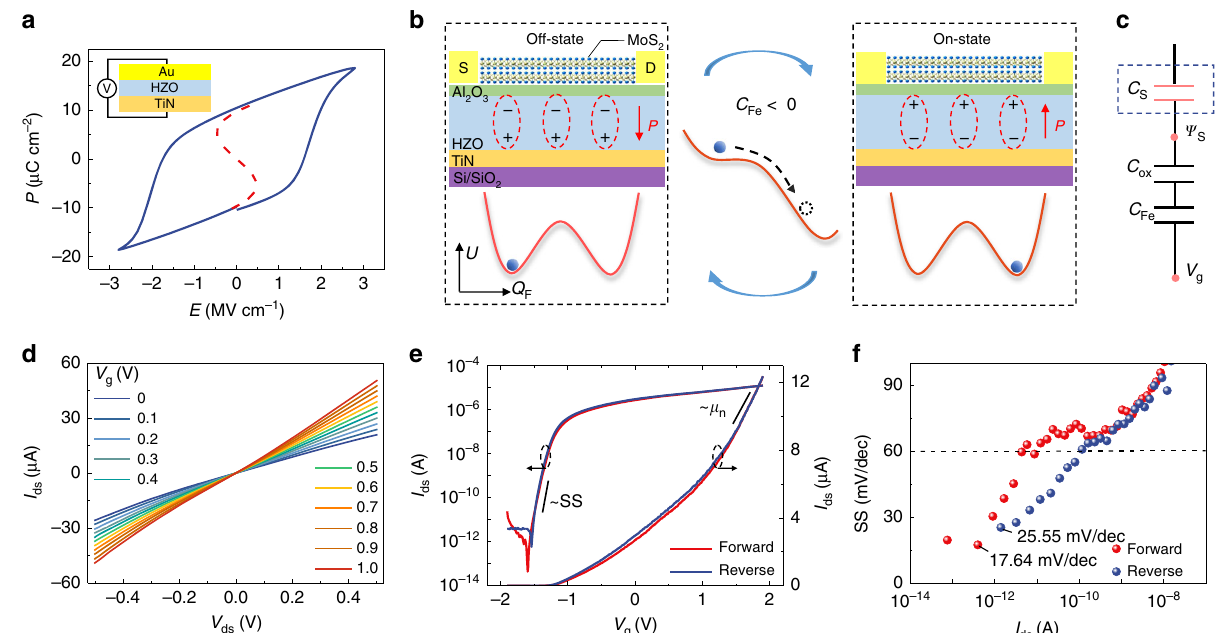
Fig. 2 Electrical measurement and results of the NC MoS 2 phototransistors. a Hysteresis loop (solid blue line) of the 10 nm-thick ferroelectric HZO thin fi lm is measured by a capacitor composed of Au/HZO/TiN layers. The dashed red line fi tted by the Landau – Khalatnikov (LK) equation E = 2 α P + 4 β P 3 + 6 γ P 5 shows negative d P /d E region. b Device working schematics and ferroelectric double well energy landscapes. During the process of ferroelectric polarization switching, the ferroelectric material is supposed to go across an energy barrier from one energy valley to another. This energy barrier is regarded as the ferroelectric NC region. c Equivalent capacitance schematic of the device, where C S , C ox and C Fe represent the capacitance of MoS 2 , Al 2 O 3 and HZO layers, respectively. d Output characteristic ( V ds – I ds ) curves exhibit ohmic characteristics for all gate voltages. e Forward and reverse transfer characteristic ( V g – I ds ) curves under V ds = 0.1 V are plotted in red and blue, respectively, and hysteresis between them is almost negligible. Electron mobility and SS are, respectively, extracted based on a linear scale (right axis) and a logarithmic scale (left axis). f SS is calculated according to the transfer characteristic curves, where the average value, the minimum values in forward and reverse (SS avg , SS min-for , and SS min-rev ) are 45, 17.64, and 25.55 mV/dec,